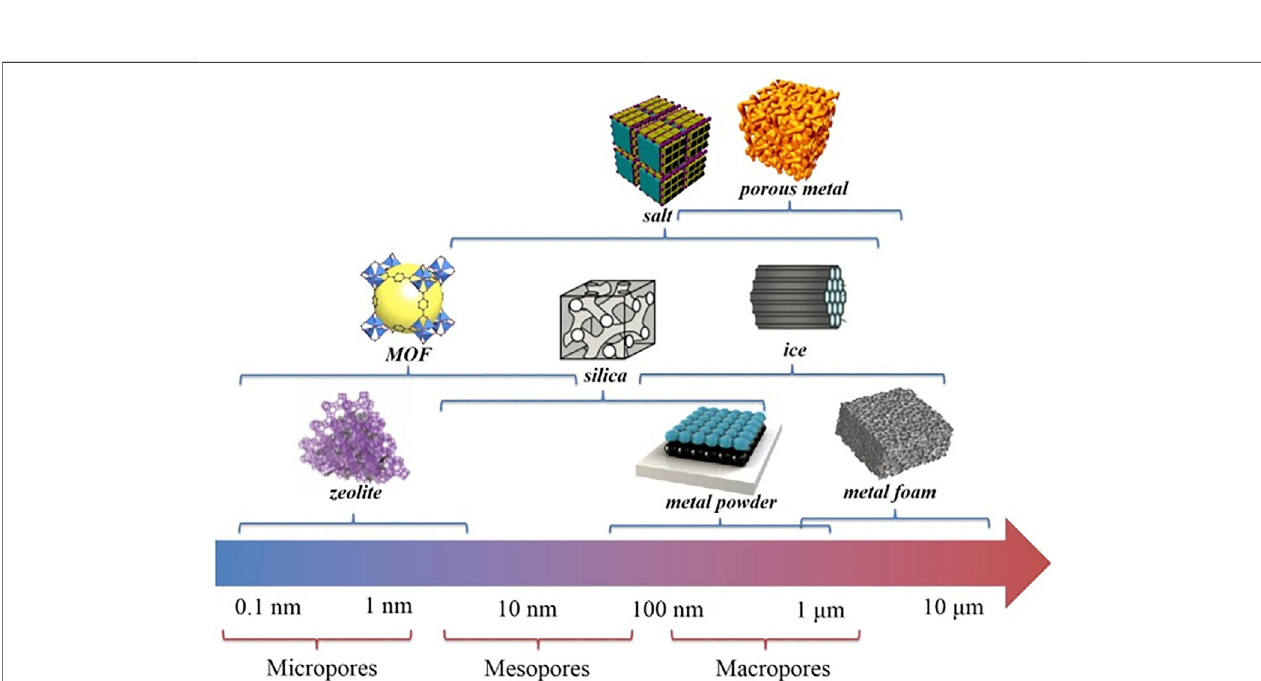
FIGURE 4 | Different types of hard templates and their corresponding length scales (Zhu et al., 2019).